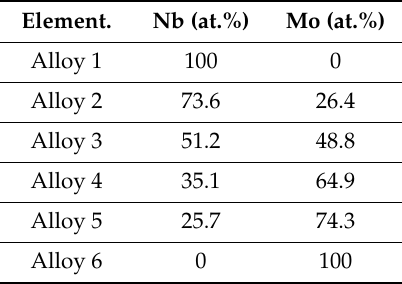
Table 1. Chemical composition of arc-melted Nb x Mo y alloys (at.%). Element. Nb (at.%) Mo